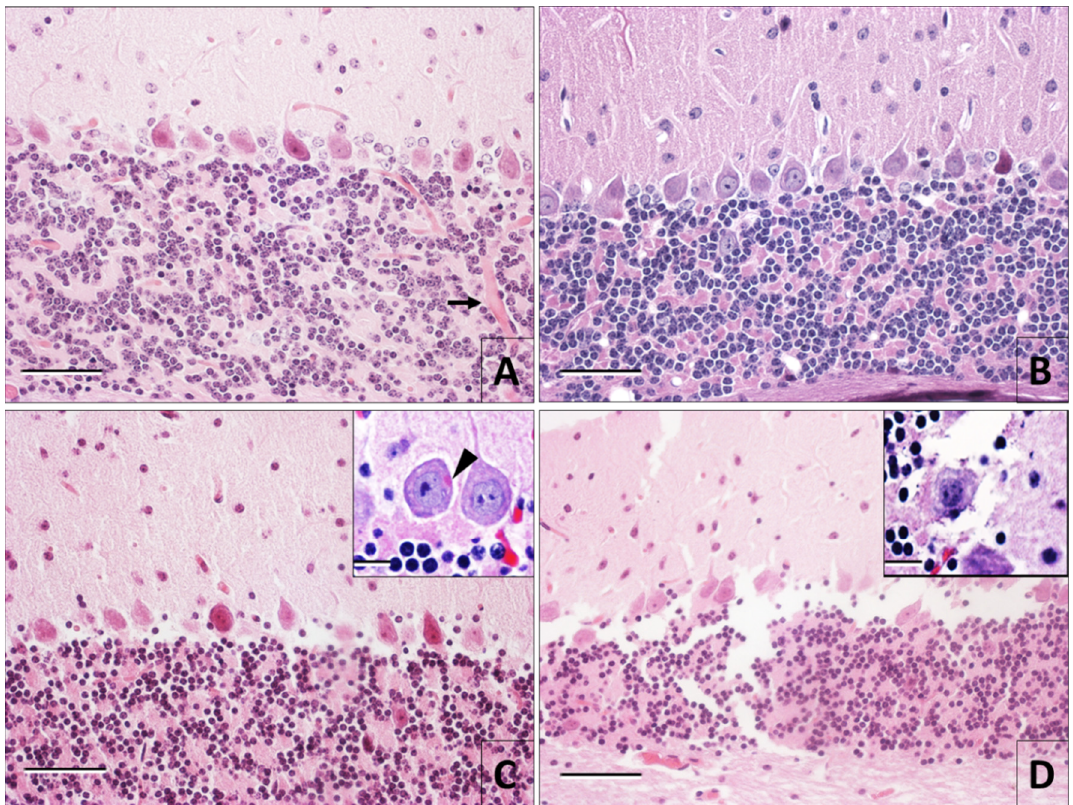
Figure 1. Hematoxylin and eosin stain in slices of cerebellum infected with rabies virus. Tissue fixed by immersion ( A ) and perfusion ( B ) at 0 h postmortem. Tissue integrity, delimitation of the cytoplasm and the neuronal nucleus, and part of the dendrites of the Purkinje cells in the perfusion-fixed samples are preserved. In the immersion-fixed tissue, blood is observed in the blood vessels (arrow). At 12 h postmortem ( C ), the tissue degradation process is clear; granulation of the neuropile does not allow the observation of dendrites. Dissolution of cytoplasm and neuronal nucleus in some Purkinje cells is also noted. Well-preserved Purkinje cells can be seen in the box, one of them with an eosinophilic inclusion in the cytoplasm (arrowhead). ( D ) Tissue with 30 h of postmortem degradation. Notice the loss of integrity and the autolysis in Purkinje cells with an absence of eosinophilic inclusions (Magnifications A-D 40×, boxes 80×) (bars 50 = 50 µm).